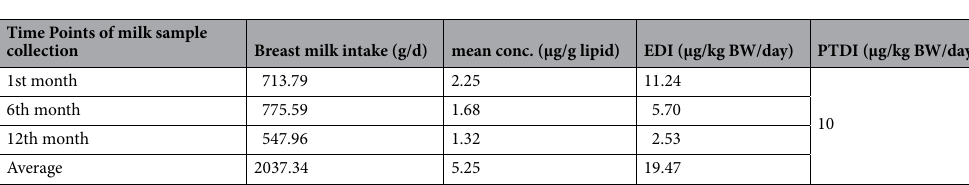
Table 4. Estimated daily intake of infants (µg/kg